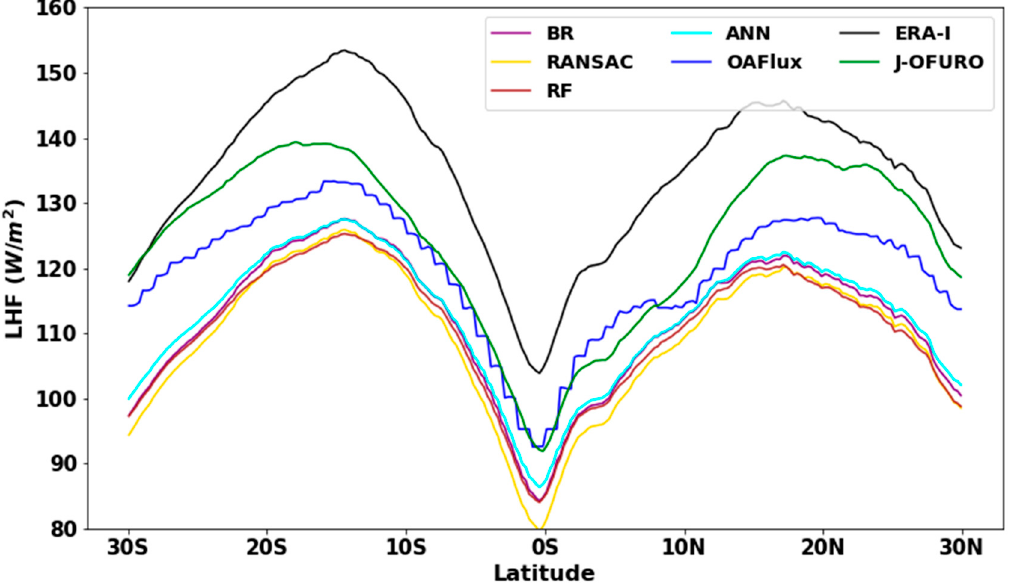
Figure 13. Latitudinal variation of annual average LHF over low-latitude area during 2003–2007, (unit W m − 2 ).